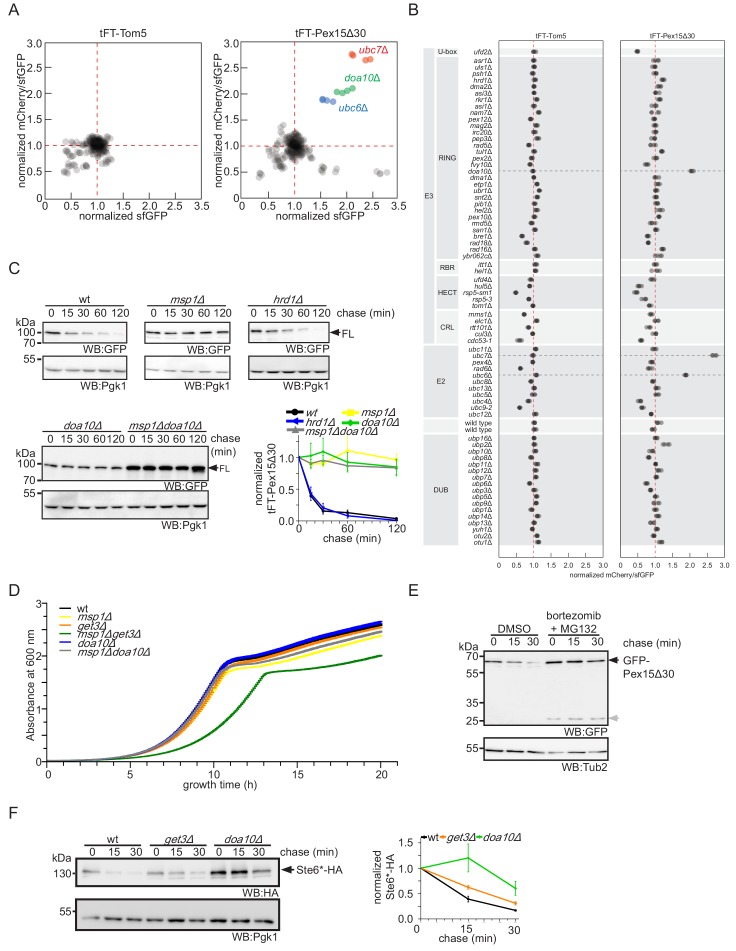
Targeted screen in ubiquitin-proteasome system mutants emphasizes role of Doa10 in Pex15Δ30 turnover.(A) sfGFP intensities and mCherry/sfGFP ratios (n = 4), normalized to the median of each screen, for tFT-Pex15Δ30 and tFT-Tom5 expressed in an array of mutants in the ubiquitin-proteasome system. (B) Normalized mCherry/sfGFP ratios for the indicated mutants in each screen. DUB, deubiquitinating enzymes, E2, ubiquitin-conjugating enzymes, E3, ubiquitin ligases. Red dashed lines mark the median of each screen. (C) Cycloheximide chase analysis and quantification (n = 3, ± SEM) of tFT-Pex15Δ30 (FL) expressed in wt, msp1Δ, doa10Δ, and msp1Δdoa10Δ, and hrd1Δ strains. WB, western blot. Pgk1 serves as loading control. (D) Growth curves of indicated yeast strains expressing tFT-Pex15Δ30 during 20 hr of growth (n = 3, ± SEM). (E) Cycloheximide chase of pdr5Δ yeast strains expressing sfGFPcp8-Pex15Δ30 pre-treated with the proteasome inhibitors MG132 (80 μM) and bortezomib (100 μM). Gray arrow, uncharacterized sfGFP degradation intermediate. (F) Cycloheximide chase of plasmid expressed Ste6*-HA in wt, get3Δ and doa10Δ strains with quantification (n = 3, ± SEM).